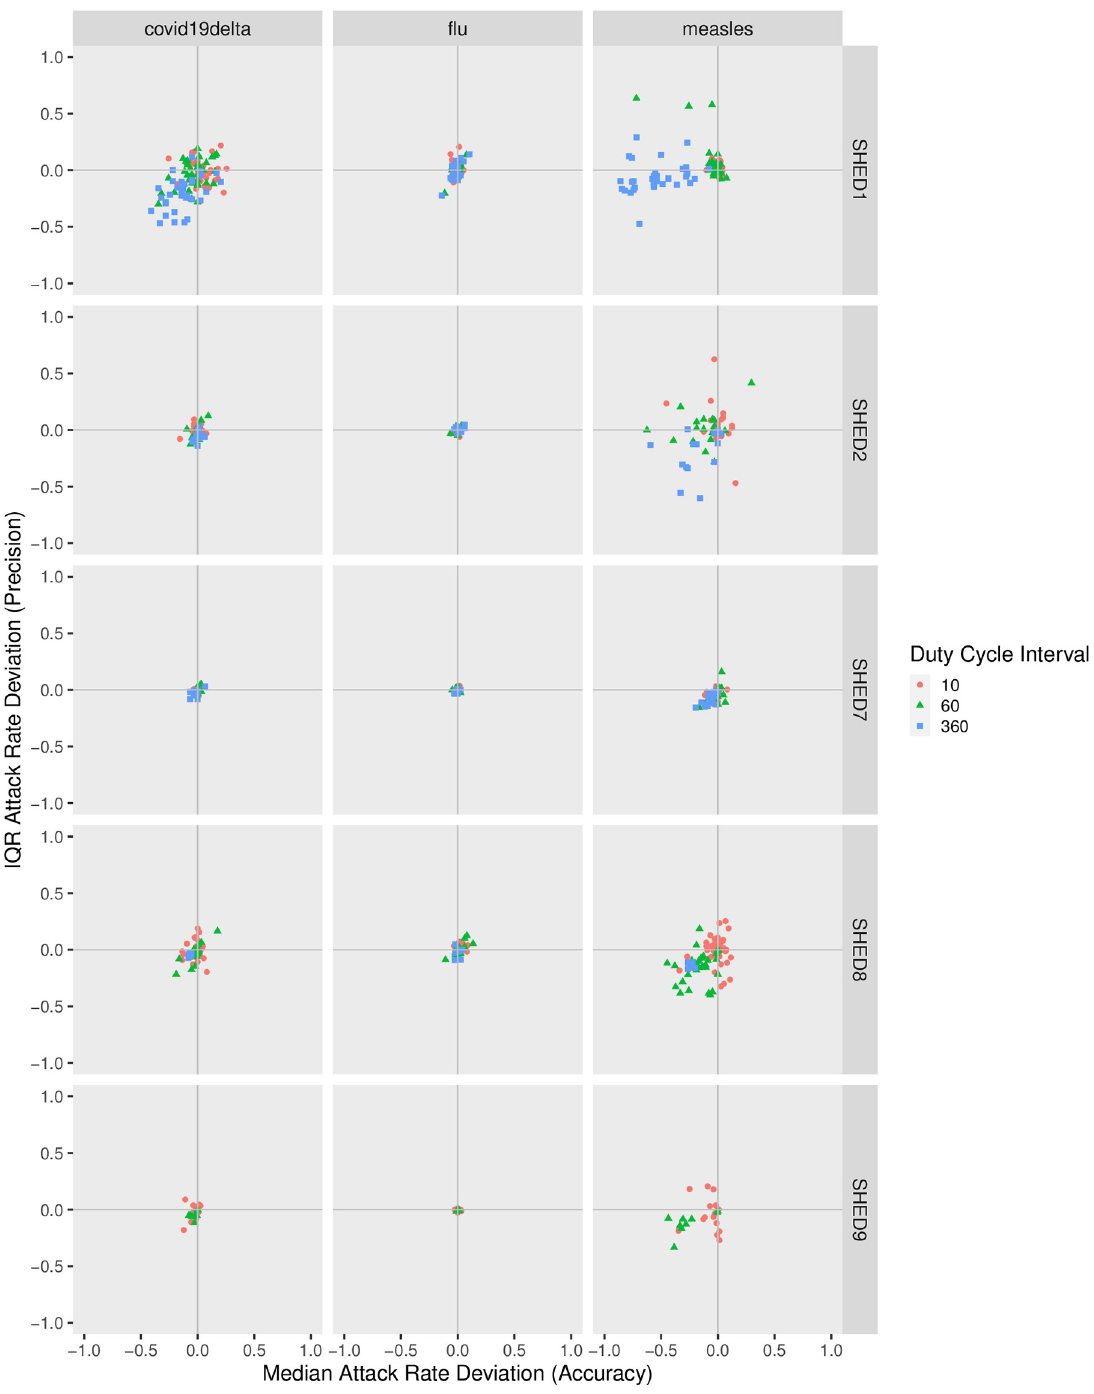
Fig 7. Attack rate given initial infection node for the Snapshot method. and for “diffuse” population such as {SHED7, SHED8, SHED9}, indicating the advantage of Snapshot at maintaining an estimate of attack rate as downsampling interval increases. For diseases with high R (measles) and “closer” communities {SHED1, SHED2}, Snapshot 0 underestimates the attack rate as ξ increases, whereas Upperbound overestimates.